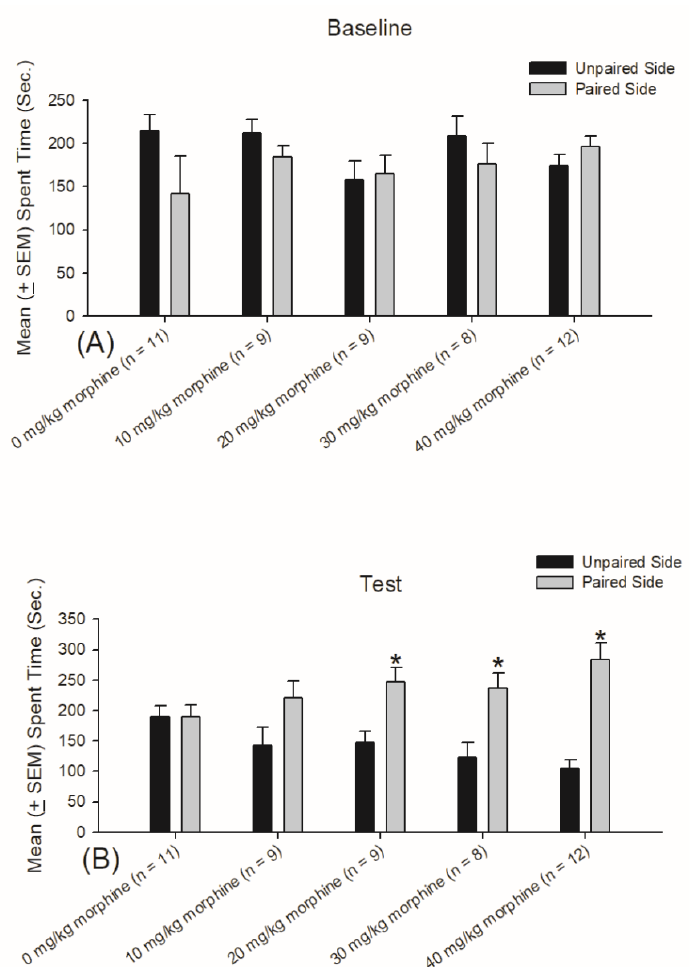
Figure 3. Morphine was acting as the rewarding US in CPP. Mean ( ± SEM) time spent on saline ( n = 11), 10 mg/kg morphine ( n = 9), 20 mg/kg morphine ( n = 9), 30 mg/kg morphine ( n = 8), and 40 mg/kg morphine ( n = 12) groups for the drug-unpaired side and the drug-paired side on the baseline ( A ) and test ( B ) sessions. Note that the drug-paired side means that morphine was injected in one compartment of the CPP box, whereas the drug-unpaired side was the saline injection in the other compartment of the CPP box. * p < 0.05 when comparing pre-conditioning and post-conditioning. Table 1. Summary of various doses of morphine in conditioned taste aversion and conditioned place